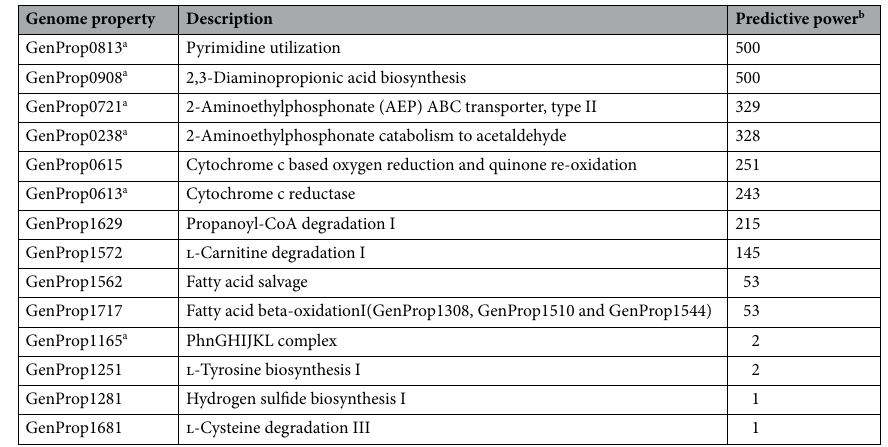
Table 3. Random Forest features importance of Genome properties related to the plant-associated lifestyle. a GP also found in the enrichment analysis. b Numbers were obtained using recursive feature elimination (500